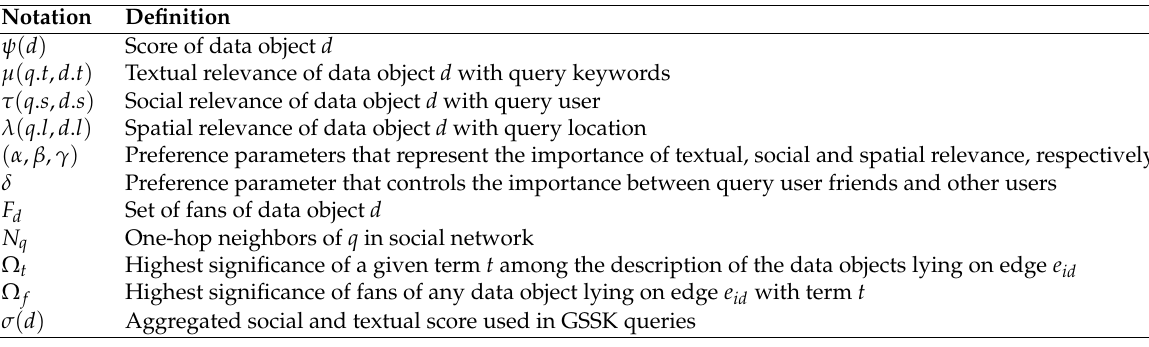
Table 1. Frequently used